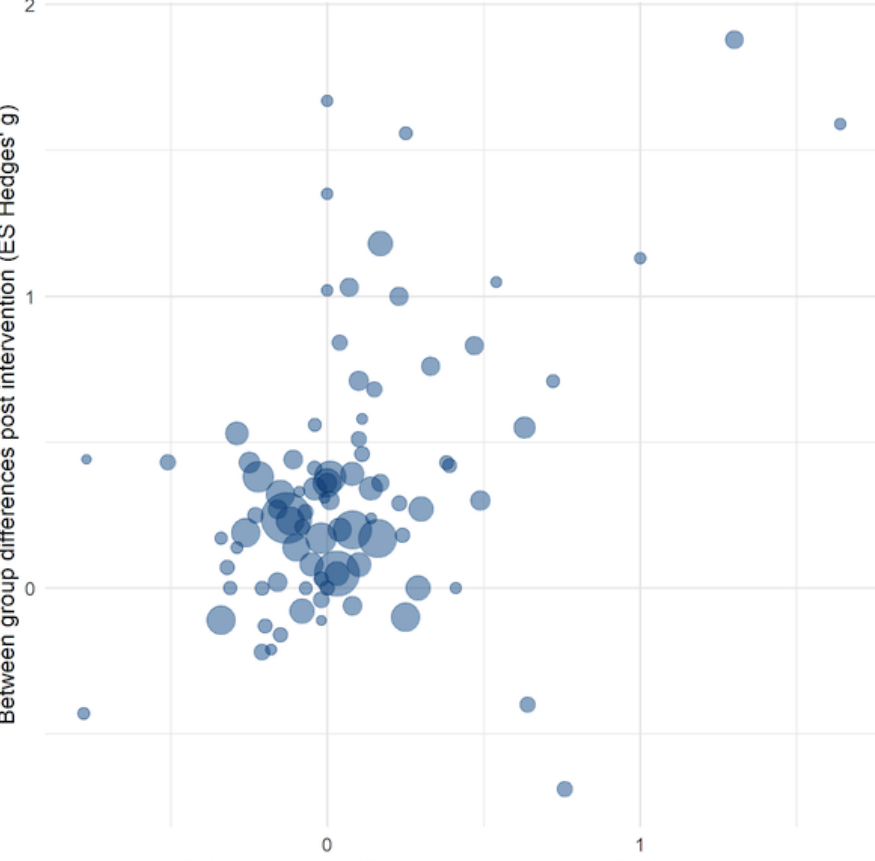
Figure 2. Scatterplot of group differences before and after the intervention for each outcome separately. Point size indicates the number of participants in each study. ES: effect